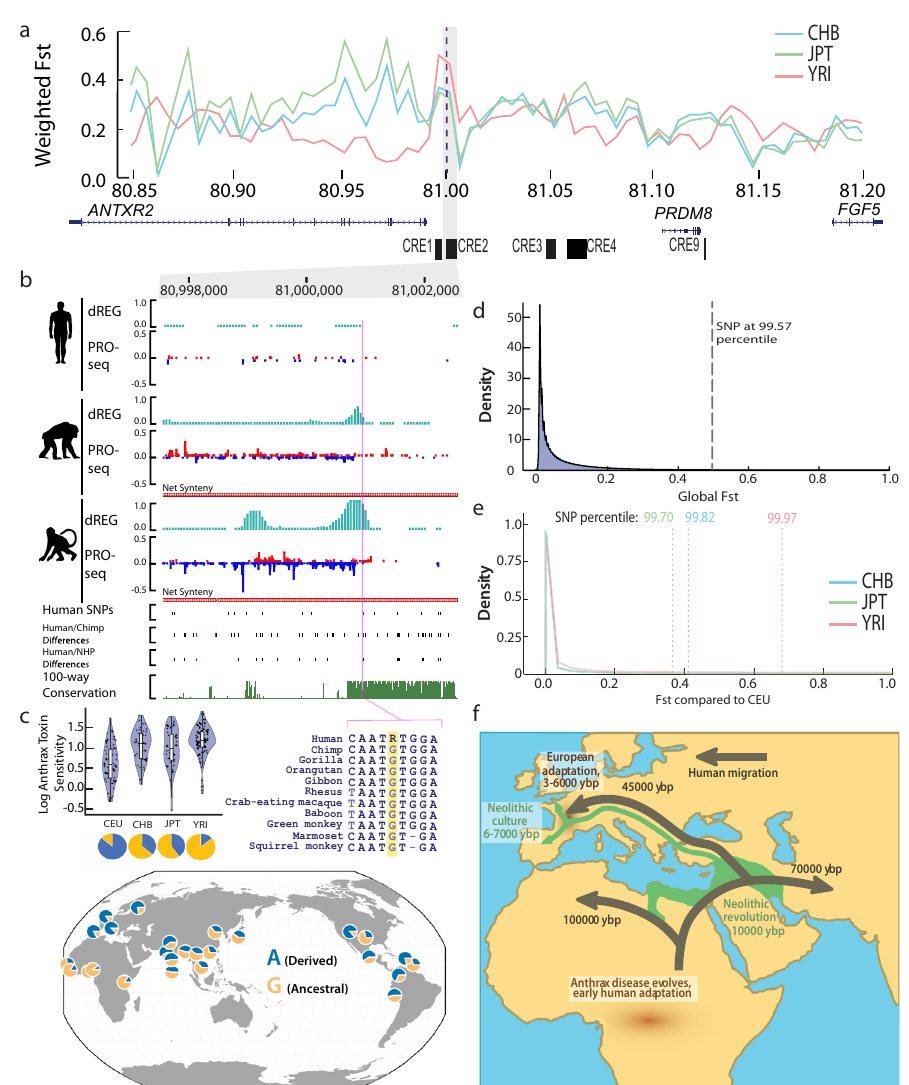
Fig. 4 Genetic differentiation in European populations consistent with multiple phases of selection driving changes in ANTXR2 . a Weighted Fst ( fi xation index) comparisons between CEU (Northern and Western Europe) and CHB (China), JPT (Japan), and YRI (Yoruba) HapMap populations at the ANTXR2 locus show a peak around ANTXR2 . b PRO-seq (normalized by reads per million) and dREG signal (pictured in teal) at cis -regulatory element 2 (CRE2). rs41407844 falls within a dREG peak shared by chimpanzee and rhesus macaque and the ancestral allele G is conserved within the primate lineage. Conservation of CRE2 between humans and non-human primate tracks show human-speci fi c single nucleotide polymorphisms (SNPs), human/ chimpanzee differences (SNPs in black, insertion/deletions (INDELS) in red), human/non-human primate differences (SNPs in black, INDELS in red), and 100-way conservation. Net synteny tracks show the position of regions that have one-to-one orthologs in the chimpanzee and rhesus macaque genomes. c Martchenko et al. 54 showed that CEU lymphoblastoid cell lines (LCLs) have lower sensitivity to anthrax toxins than LCLs derived from other populations. Data are presented as mean values + / − SD (CEU n = 60, CHB n = 43, JPT n = 44, YRI n = 84). The allele frequency of SNP rs41407844 across populations. Source data are provided as a Source Data fi le. d Genome-wide global Fst distribution 84 . The SNP rs41407844 is above the 99.57 percentile of Fst of all SNPs genome-wide. e Rs41407844 is above the 98% percentile for pairwise Fst comparisons between CEU and CHB, JPT, and YRI HapMap populations genome-wide. f Model demonstrating the pattern of human migration (dark green) compared to the spread of Neolithic culture (light green) and anthrax disease distribution